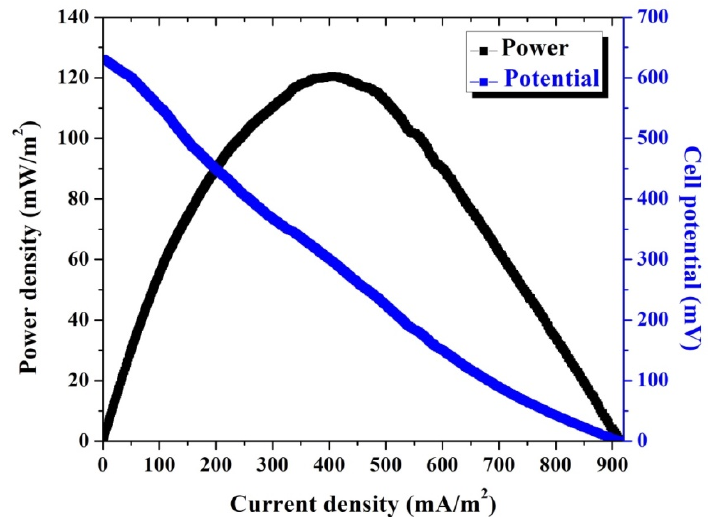
Figure 8. Polarization and power density curves of batch-mode and single-chamber MFCs using a cobalt-incorporated carbon nanofiber anode after 24 h batching time.